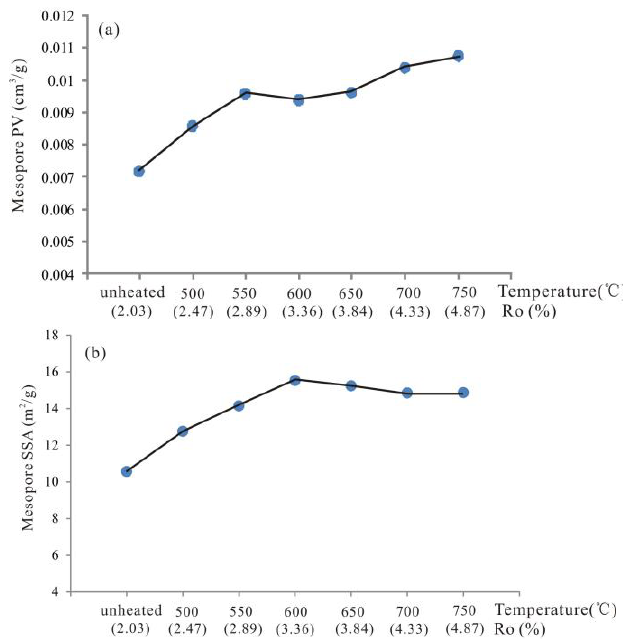
Figure 5. ( a ) Relationships between mesopore PV and temperature (%Ro), ( b ) relationships between mesopore SSA and temperature (%Ro).